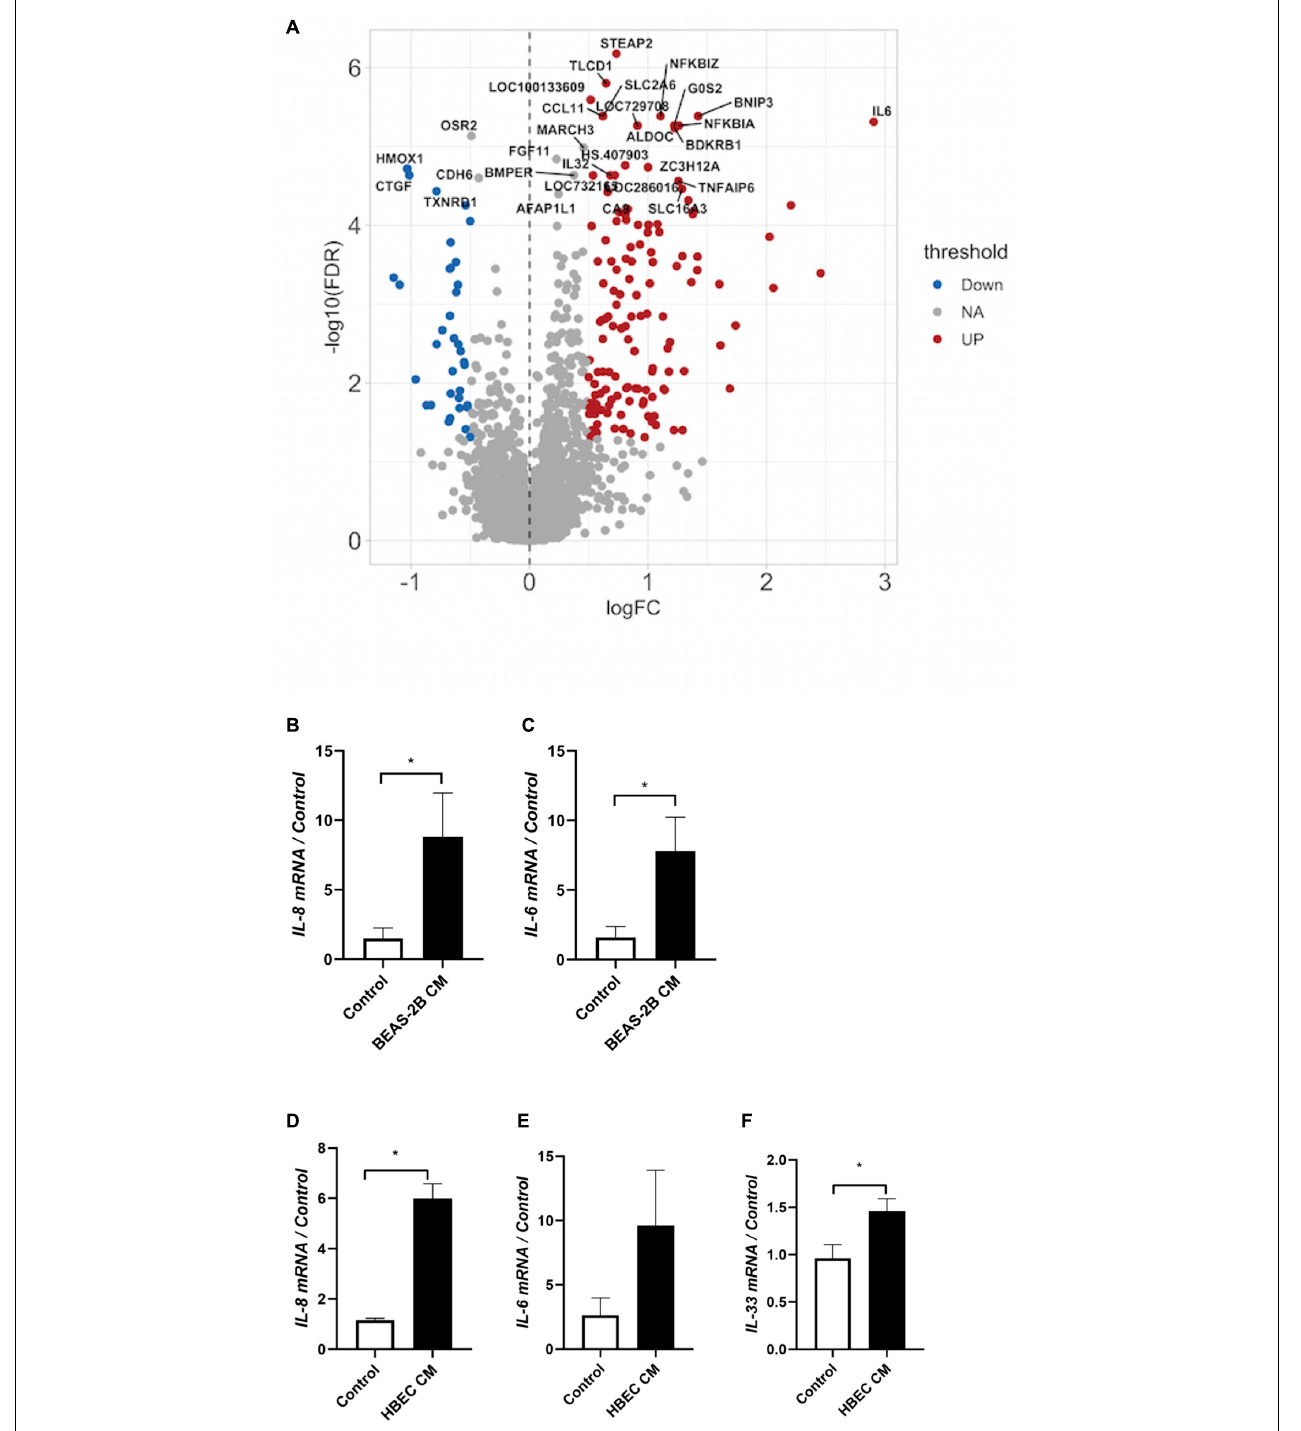
FIGURE 4 | Co-culture induces the expression of inflammatory cytokines. (A) Messenger RNA was extracted from co-cultured or not co-cultured (control) ASMCs and gene array analysis was performed by Illumina HT-12 version 4 Expression BeadChip (Illumina) ( n = 6). Gene array analysis was performed using FlexArray software and a Cyber-T test followed by a Benjamini–Hochberg P -value correction for multiple comparisons. The top 30 statistically significant genes are labeled on the volcano plot. Red indicates upregulation, blue indicates downregulation. FDR, false discovery rate; FC, fold change. (B,C) mRNA was extracted from ASMCs that had either been stimulated with conditioned medium from BEAS-2B cells, or stimulated with medium that was not conditioned by BEAS-2B cells. RT-qPCR was performed ( n = 5). (D–F) mRNA was extracted from ASMCs that had either been stimulated with conditioned medium from well-differentiated human bronchial epithelial cells (HBECs) cultured at the air–liquid interface (ALI), or stimulated with medium that was not conditioned by HBECs. RT-qPCR was performed ( n = 3). Data are representative of means + 1 SE. * P < 0.05.